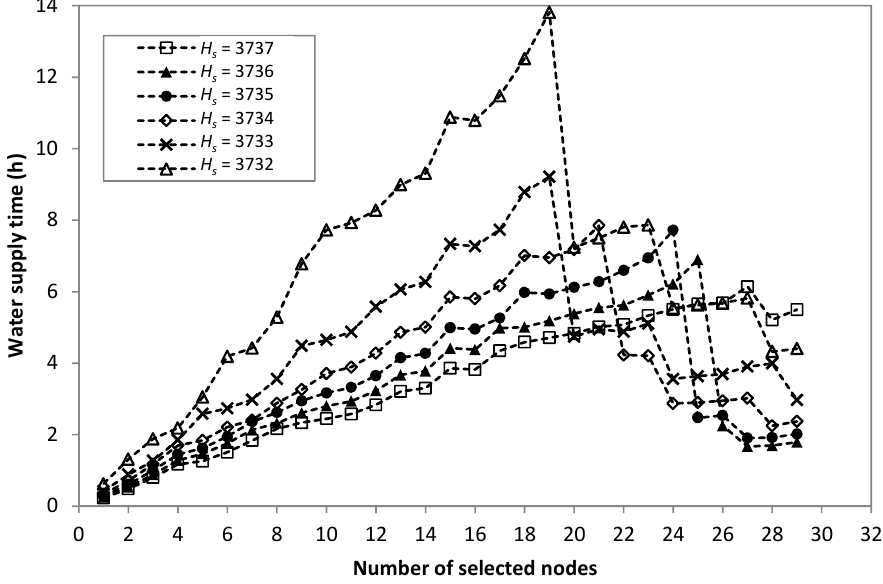
Figure 10. Variation of the water supply time as a function of the selected nodes and the head in the water supply source.